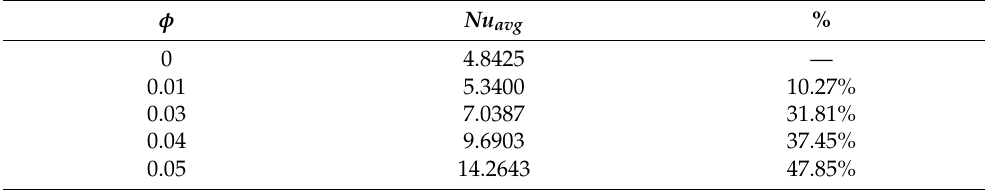
Table 3. Impact of volume fraction on Nusselt number with percentage